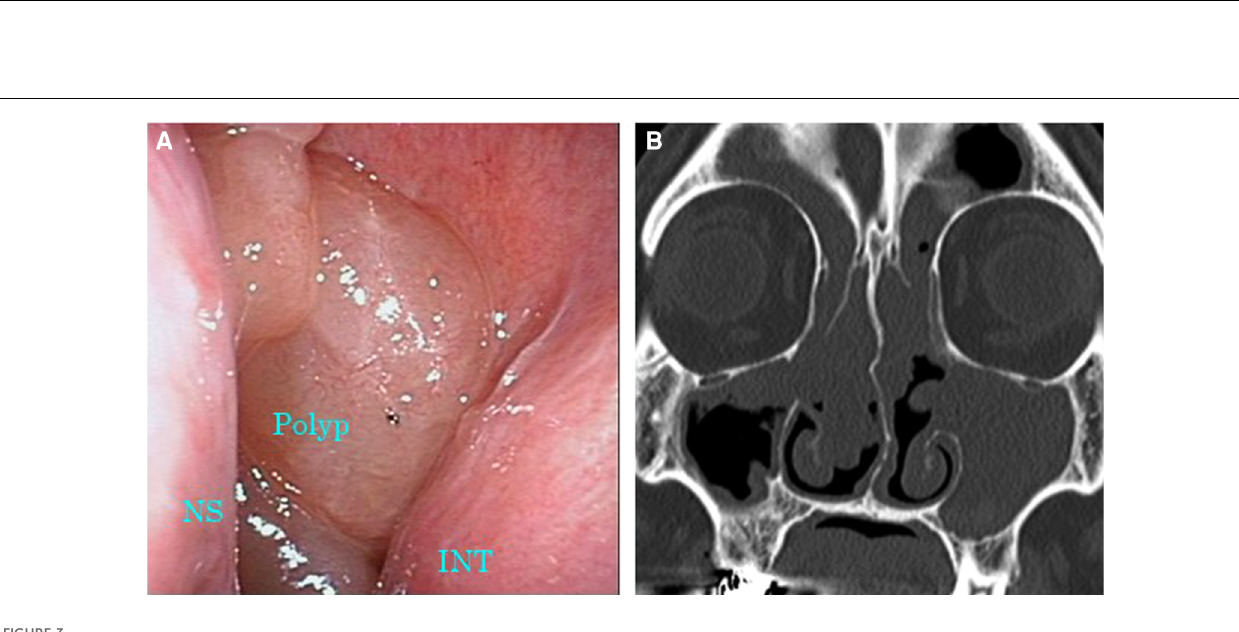
FIGURE 3 Images of nasal endoscopy and sinus CT 6 months after the initiation of dupilumab therapy. ( A ) Nasal polyps occupying the common nasal meatus were still observed. ( B ) Soft tissue density fi lled all sinuses on both sides. CT, computed tomography; INT, inferior nasal turbinate; NS, nasal